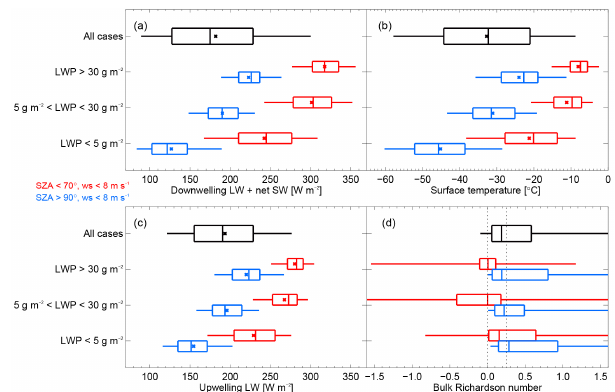
Figure 8. Linear regression of data from July 2013 to June 2014. (a) Total response (SH, LH, − LW ↑ , and G ) as a function of the forcing terms (LW ↓ + net SW). (b) LW ↑ , (c) conductive heat, (d) sensible heat, and (e) latent heat flux as a function of the forcing terms. The slope of the best fit linear regression is included in each